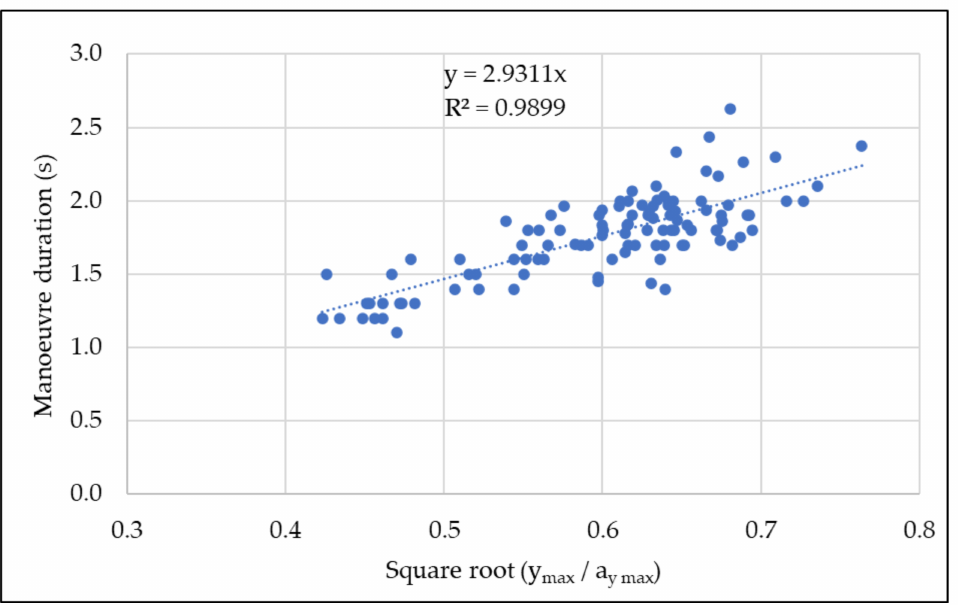
Figure 3. Data regression analysis.